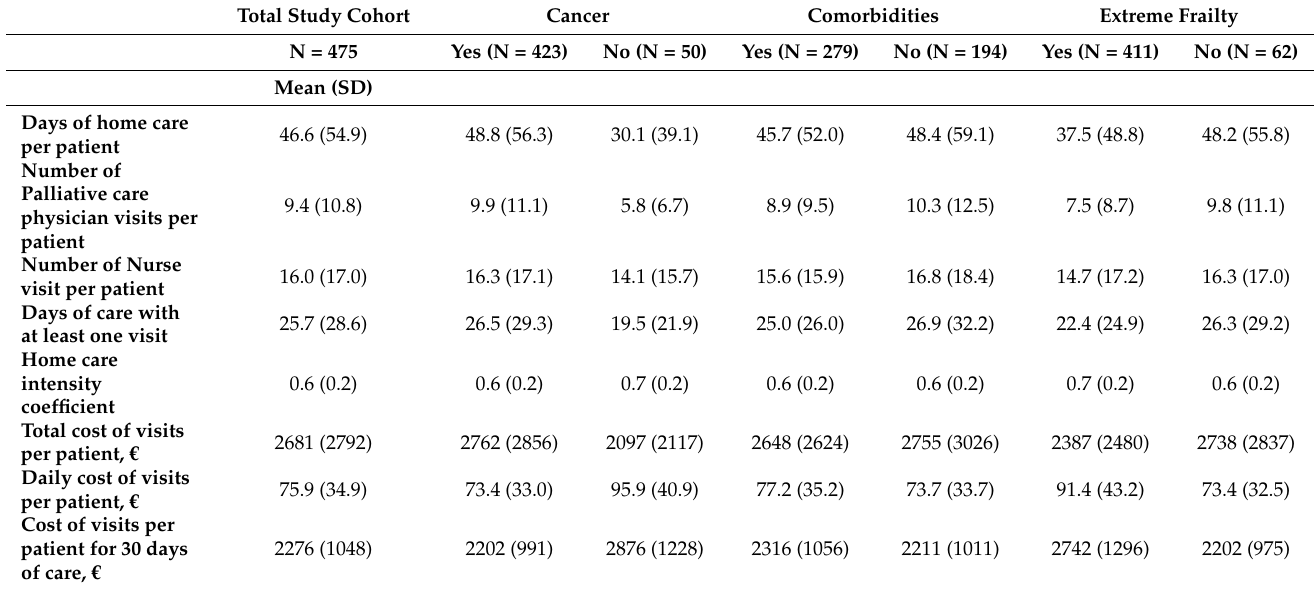
Table 3. Healthcare characteristics of the outpatient palliative care paths, overall and stratified by cancer, comorbidities and extreme